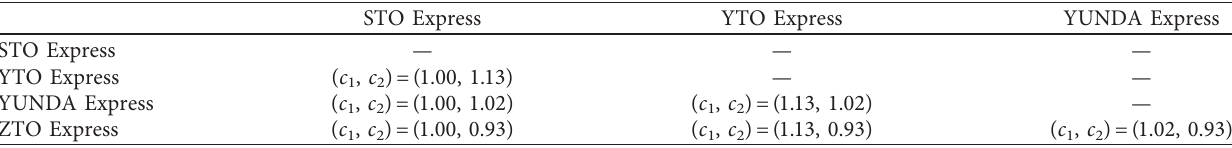
Table 5: Unit transportation cost combination of two-two